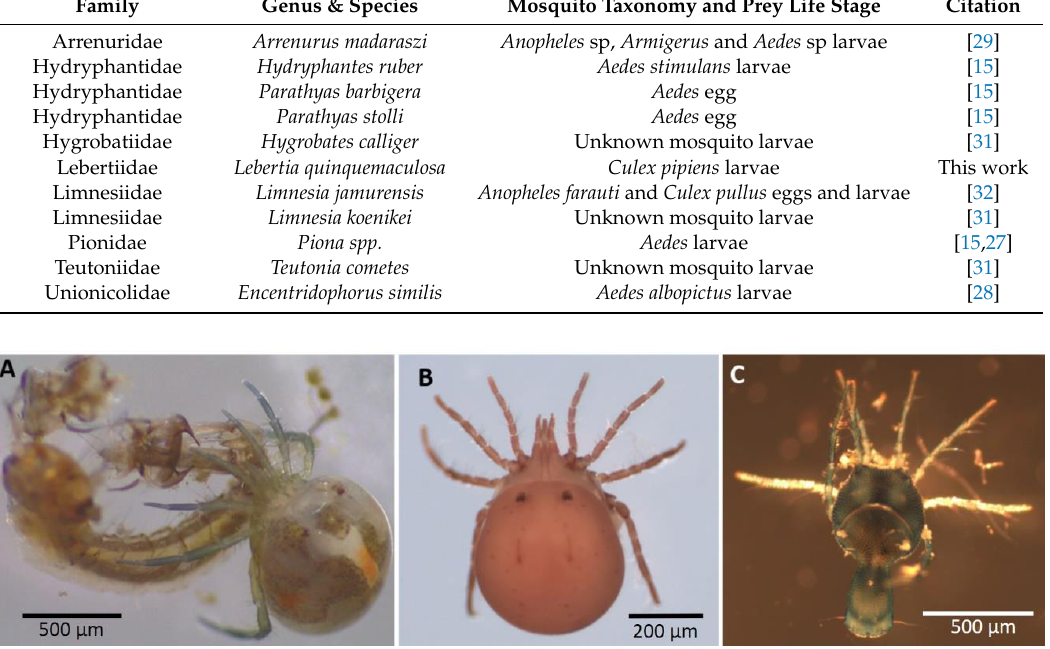
Figure 3. Micrographs of representative water mites used in mesocosms experiments: ( A ) Lebertia quinquemaculosa seen consuming a Culex pipiens larvae; ( B ) Hydrachna (ventral view), and ( C ) Arrenurus (ventral view). Table 2. The biodiversity of water mite predators of mosquitoes.